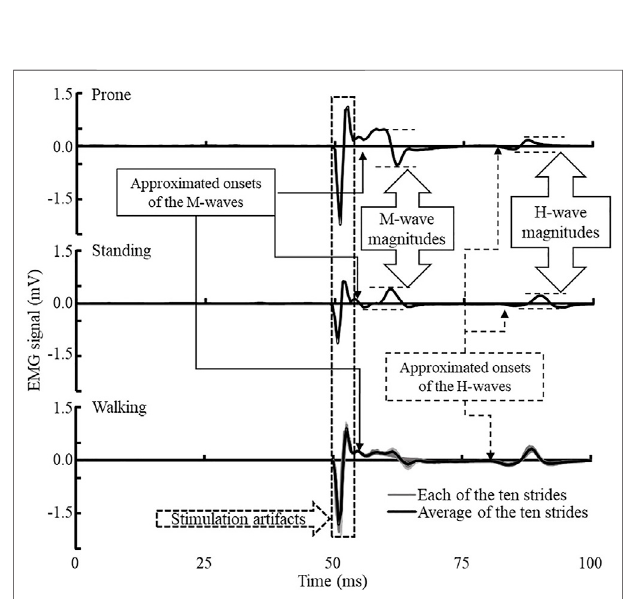
FIGURE 2 | Exemplar H-re fl ex EMG data of prone (upper), standing (middle), and walking heel-contact (lower) conditions. The onsets of H- and M-wave were the fi rst de fl ection after a short stabilized period of the EMG signals. Walking EMG collection was triggered by the footswitch at foot contact, and no background EMG was collected before the H-re fl ex signals. Background EMG signals were negligible compared to the magnitudes of the M- and H-waves during all three